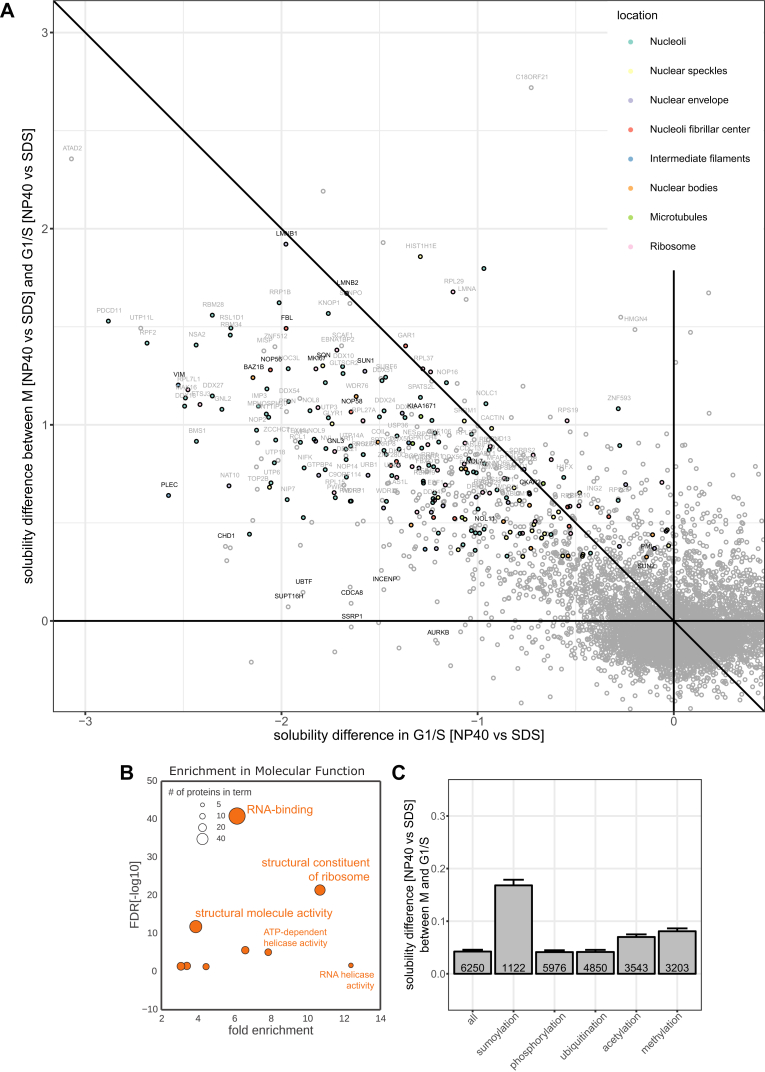
Related to Figure 7(A) Scatterplot comparing the solubility of proteins in G1/S and the relative change in solubility of proteins in mitosis versus G1/S. Proteins with negative x axis values and close to zero y axis values are insoluble in G1/S and remain insoluble in mitosis. Proteins with negative x axis values and positive y axis values are insoluble in G1/S and become more soluble in mitosis.(B) GO analysis using DAVID (https://david-d.ncifcrf.gov/) was conducted on the protein set that is significantly more soluble in mitosis versus G1/S. The scatter illustrates the fold-enrichment against the respective FDR for terms derived from the broad category “molecular function.” The size of each bubble relates to the number of proteins identified for each term.(C) Solubility differences in mitosis versus G1/S of all proteins, and proteins annotated with different post-translational modifications (specified in the STAR Methods). SEM is shown.